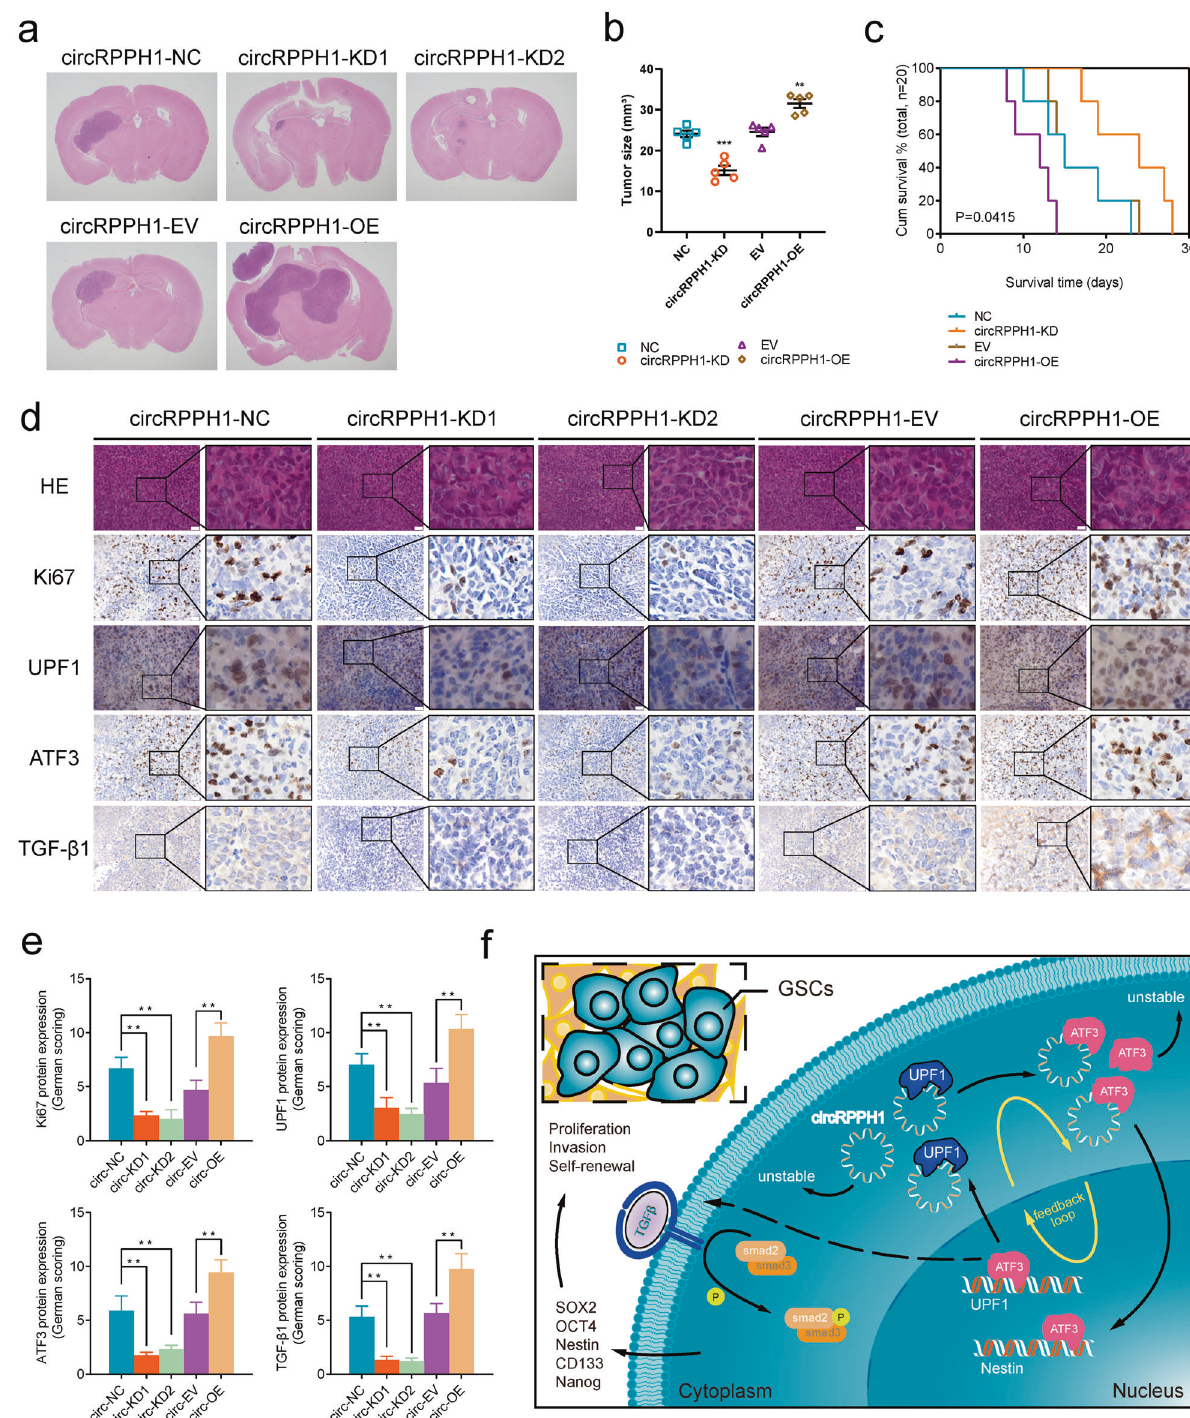
Fig. 8 UPF1/circRPPH1/ATF3 feedback loop regulates glioma tumorigenesis in vivo. a Hematoxylin and eosin staining of intracranial tumor plantation showed the tumor size in the coronal location of eight groups. Scale bar = 10 mm. b The tumor volumes measured among eight groups are indicated. (nc vs. kd: p < 0.001; ev vs. oe: p = 0.0015; Student ’ s t-test). c Kaplan-Meier survival curves showed that circRPPH1-KD prolonged the survival of mice while circRPPH1-OE shortened the survival. (For each group, n = 5, nc vs. kd: p = 0.0415; ev vs. oe: p = 0.0180; Log-rank test). d Immunohistochemical staining showed that the protein expression was decreased by circRPPH1-KD and increased by circRPPH1-OE. Scale bar = 20 μ m. e The German scoring of the protein expression in each group. (Ki67: p < 0.01; UPF1: p < 0.01; ATF3: p < 0.01; TGF- β 1: p < 0.01 Student ’ s t-test). f Schematic diagram displayed the whole UPF1/circRPPH1/ATF3 feedback loop, which promoted the malignant phenotype of glioma and stemness of GSCs through the TGF- β 1 signaling pathway. All results are obtained as the mean ± SD under at least biological triplicate assays. * p < 0.05, ** p < 0.01, *** p < 0.001.